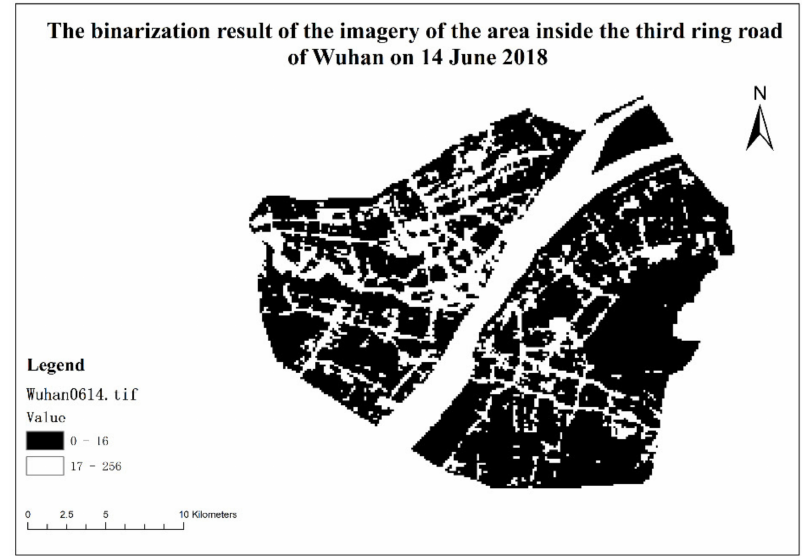
Figure 2. The binarization result of the imagery of the area inside the third ring road of Wuhan on 14 June